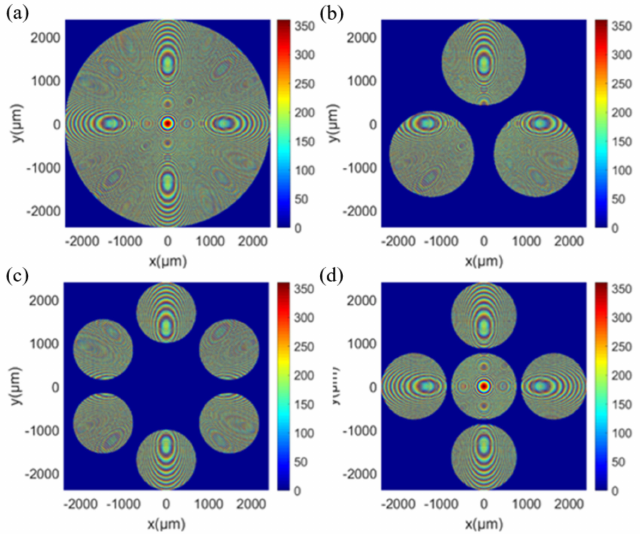
Figure 8. ( a – d ) The phase distributions of SAMs with structures of the full − aperture, Golay3, Annulus and Cross,